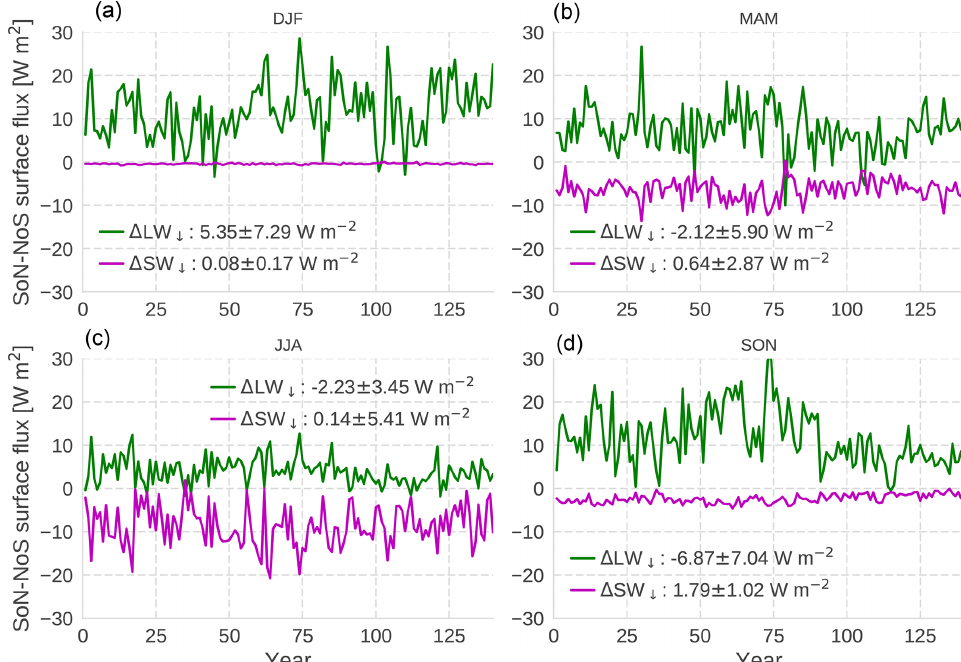
Figure 6. The 1pctCO2 CESM1-SoN-minus-CESM1-NoS season differences in downward surface fluxes over 60–90 ◦ N oceans. The legend reports the estimate of the 140-year change in this difference by multiplying the linear regression trend coefficient by 140, with ± 2 σ uncertainties. (a) December–January–February, (b) March–April–May, (c) June–July–August and (d)